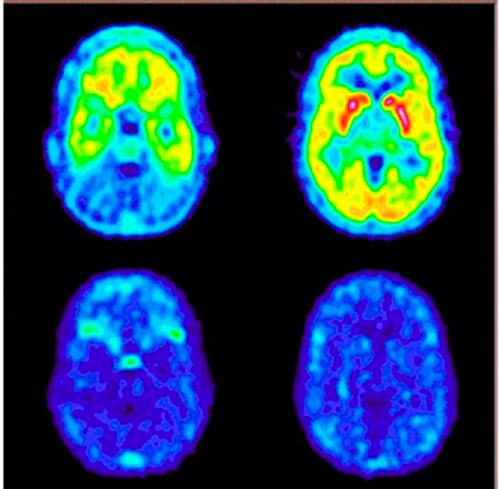
Figure 8. Predose (upper) and 100 mg aprepitant postdose (bottom) PET scans in the transverse section at the level of cerebellum (left) and striatum (right) in a human subject. Warmer colours symbolise higher uptake of radiotracer [ 18 F]SPA-RQ. Based on ratio method with cerebellum reference, estimated receptor occupancy by aprepitant for this subject was 94% at 1053 ng / mL of aprepitant in plasma [163]. NK1R occupancy PET mapping by the [ 18 F]SPA-RQ radiotracer was also applied in later